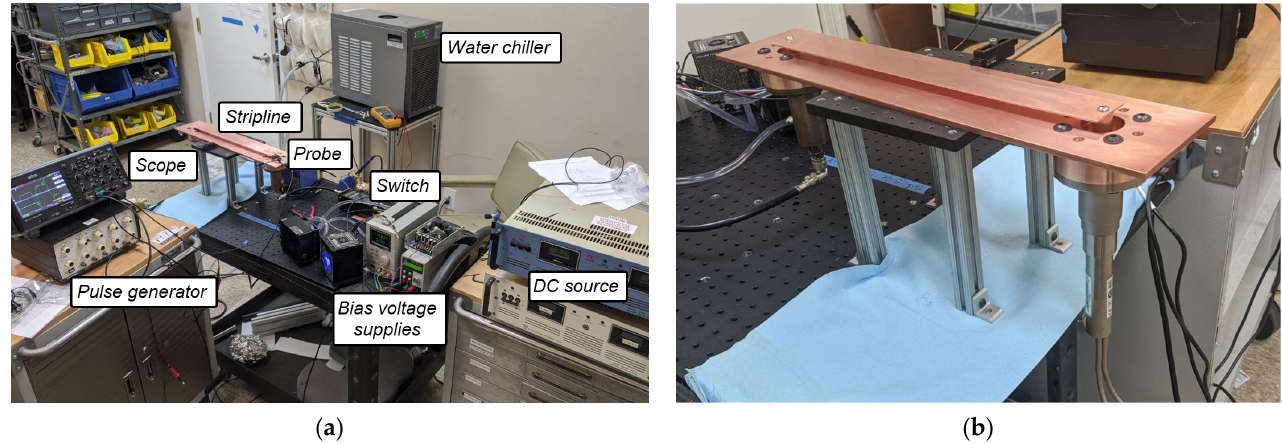
Figure 8. High-power test stand for high-voltage (HV) switch ( a ) and a close-up photo of the stripline ( b